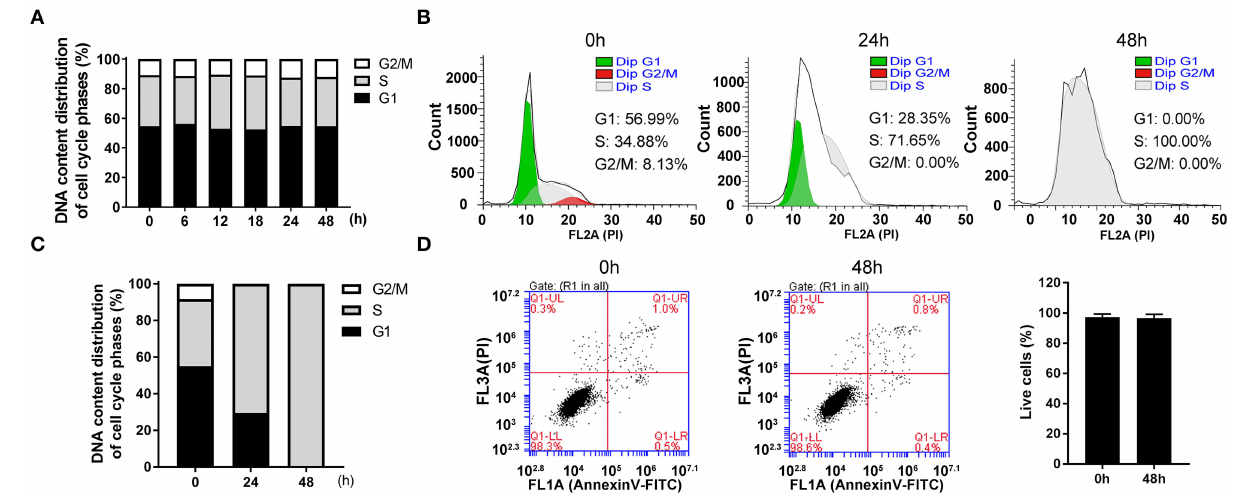
FIGURE 1 | The highly synchronized cells in S phase were induced by thymidine for 48h. (A) The distributions of cell cycle at indicated time after seeding asynchronous HepG2 cells. (B) Flow cytometric analysis showed the changes of cell cycle distributions after treatment with 1mM thymidine for 0, 24, and 48h, and the percentages of cells in G1, S and G2/M phases were statistically shown in (C) . (D) After treatment with 1mM thymidine for 48h, AnnexinV-FITC/PI staining was employed to assess cell apoptosis, and the percentage of live cells was shown in the histogram. All data were denoted as the means ± SD; N = 3.